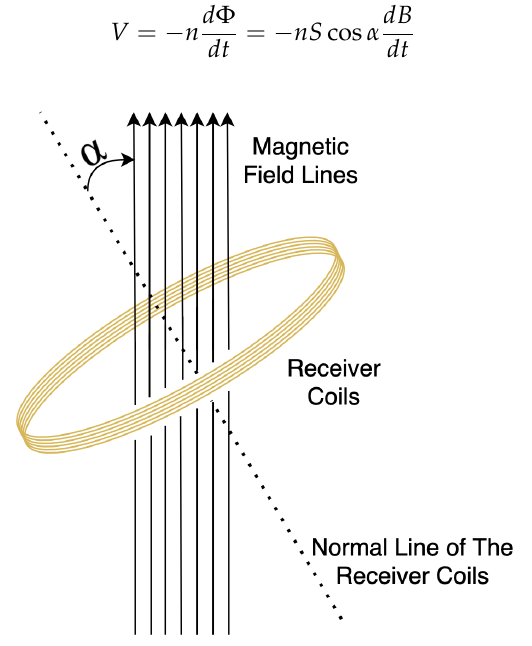
Figure 1. Receiver coil in an oscillating magnetic